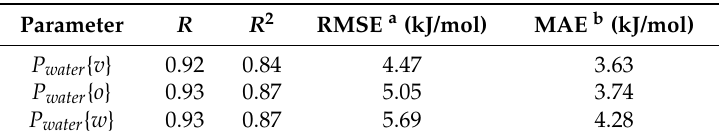
Table 1. Summary of free energy in water